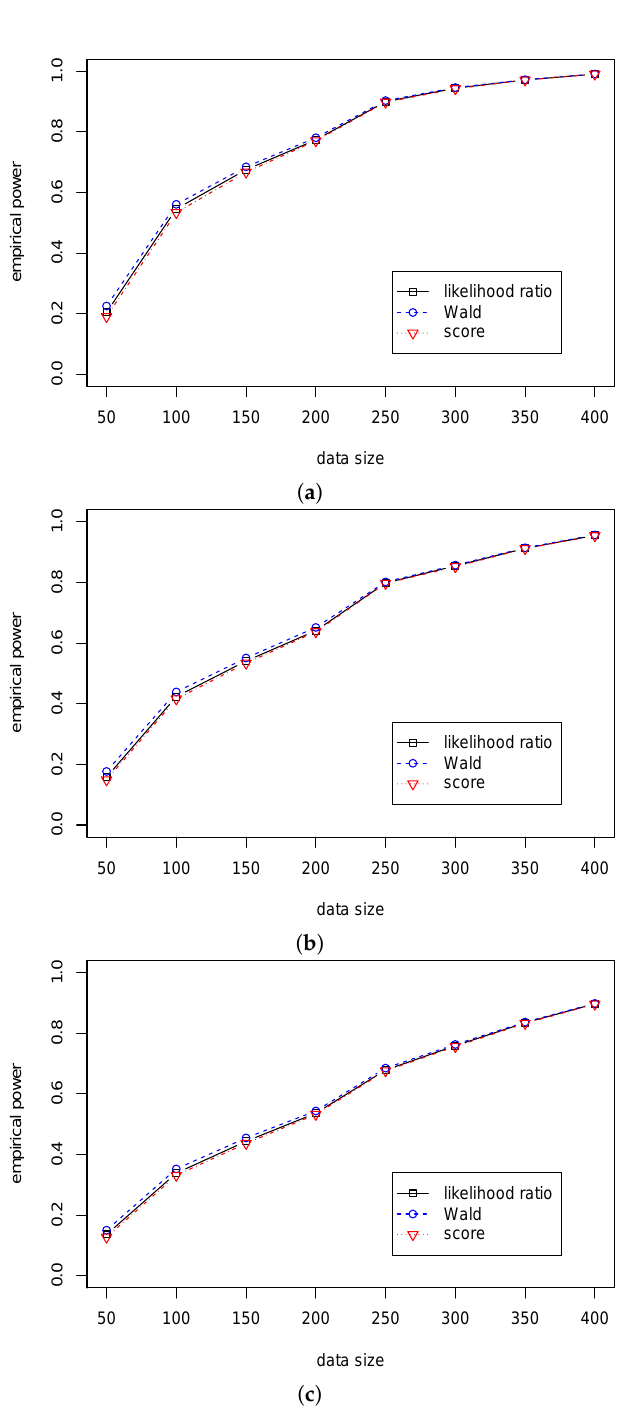
Figure 2. The empirical powers of three test statistics ( T L , T W , T S ) for testing H 0 : β 1 = 0 in Case (A2) for different α ’s. ( a ) The empirical power with H 1 : β = ( 1,0.5 ) (cid:62) for α = 0.75; ( b ) The empirical power with H 1 : β = ( 1,0.5 ) (cid:62) for α = 0.85; ( c ) The empirical power with H 1 : β = ( 1,0.5 ) (cid:62) for α =